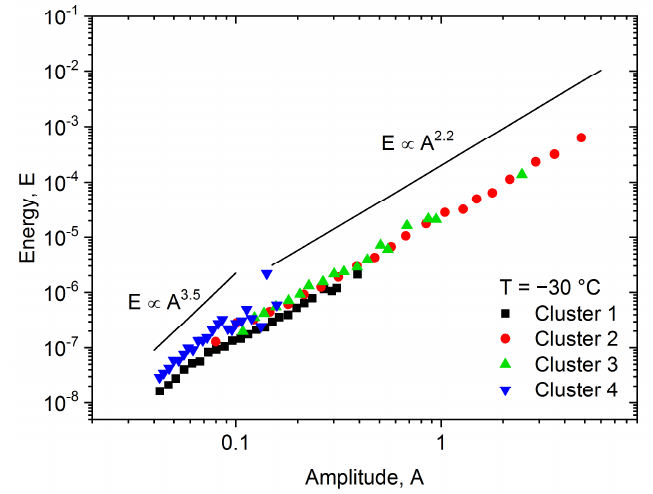
Figure 3. Energy vs. amplitude correlation for all clusters obtained at − 30 °C. The exponent of the scaling relation is in the acceptable range only for Clusters 2 and 3 (and for a part of Cluster 1), while for Cluster 4 it is out of the predicted range (>3).